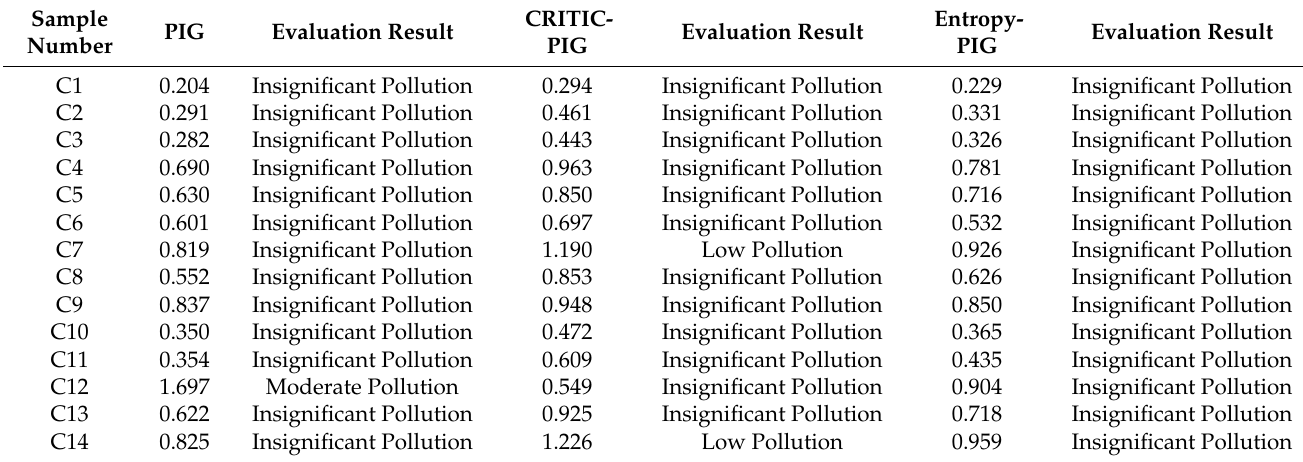
Table 6. Three PIG values and evaluation results of 14 confined groundwater